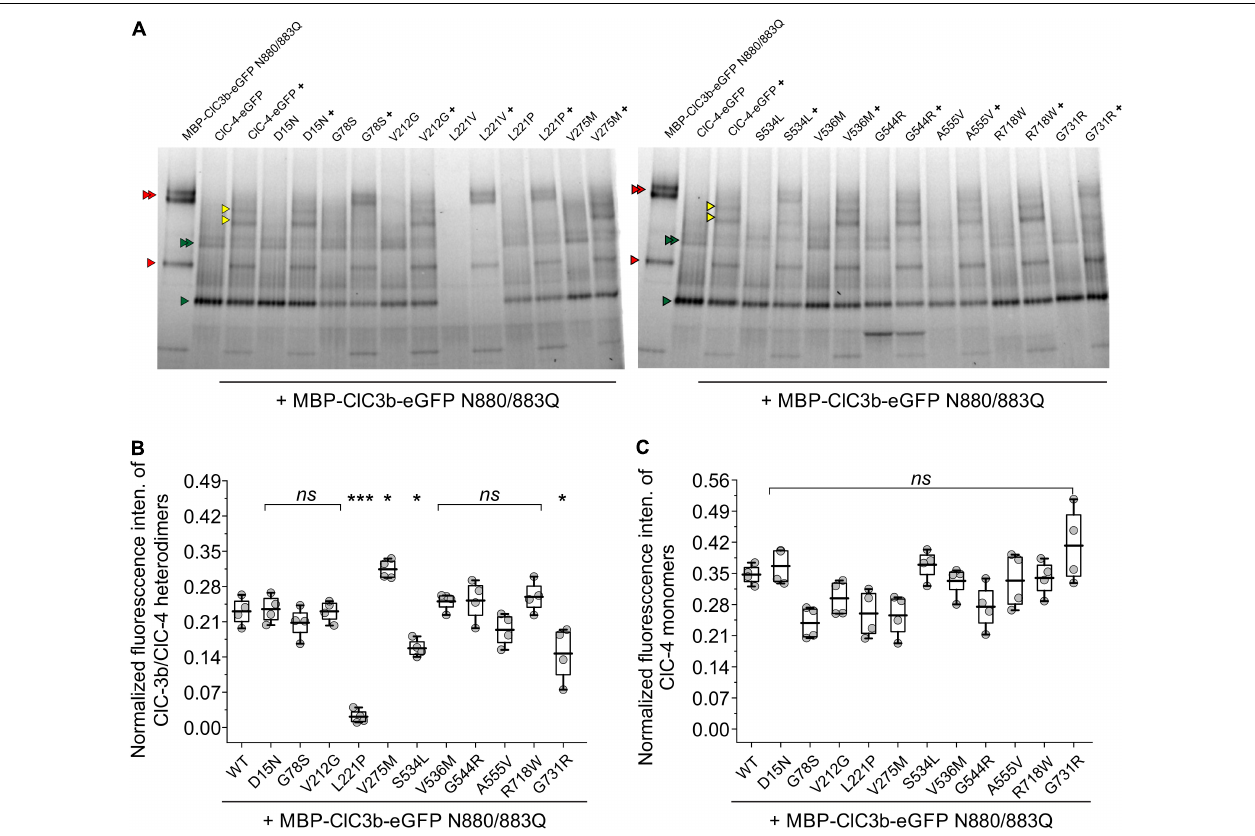
FIGURE 9 | Quantification of the oligomerization capacity of ClC-4 mutant variants. (A) hrCNE analysis of ClC-3b or WT/mutant ClC-4 after heterologous expression in HEK293T cells. Red triangles indicate ClC-3b monomer and ClC-3b homodimer bands, green triangles indicate ClC-4 monomer and ClC-4 homodimer bands, yellow triangles indicate heterodimer ClC- 3b/ClC-4 bands. The homodimers, as well as the heterodimer, appear as double bands in the gel due to its glycosylation status. Non-glycosylated protein, lower band and glycosylated protein, upper band. Glycosylated ClC-4 monomer bands are not indicated explicitly but run in between ClC-4 monomer and ClC-3b monomer band. (B) Relative fluorescence intensities of ClC-3b/ClC-4 heterodimeric bands. (C) Normalized fluorescence intensities of ClC-4 monomers. *** p < 0.001, *p < 0.05, and ns (not significant). ClC-4 variants plus ClC-3b were compared with WT plus ClC-3b using one-way analysis of variance (with Tukey’s HSD post hoc testing). Data were obtained from four independent transfections/gels and are presented as boxplot boxes indicating upper and lower quartiles; whiskers indicate upper and lower